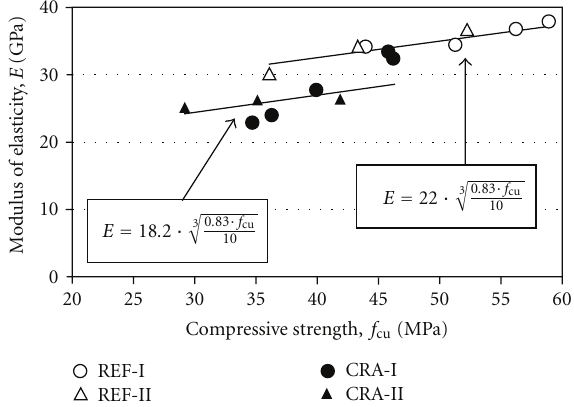
Figure 3: Static elastic modulus versus compressive strength after 28-days of wet curing.